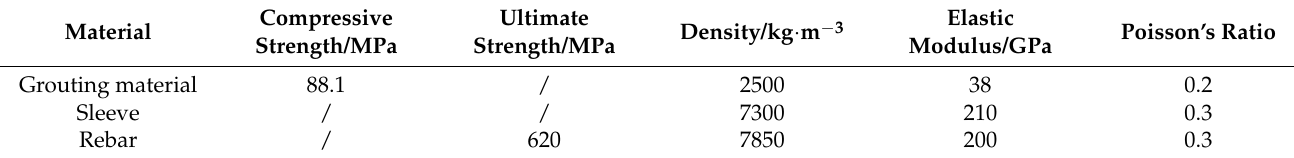
Figure 17. Stress – strain curves of materials. ( a ) Uniaxial compressive strength of concrete. ( b ) Uniaxial tensile strength of concrete. ( c ) Grouting sleeve. ( d ) Rebar.